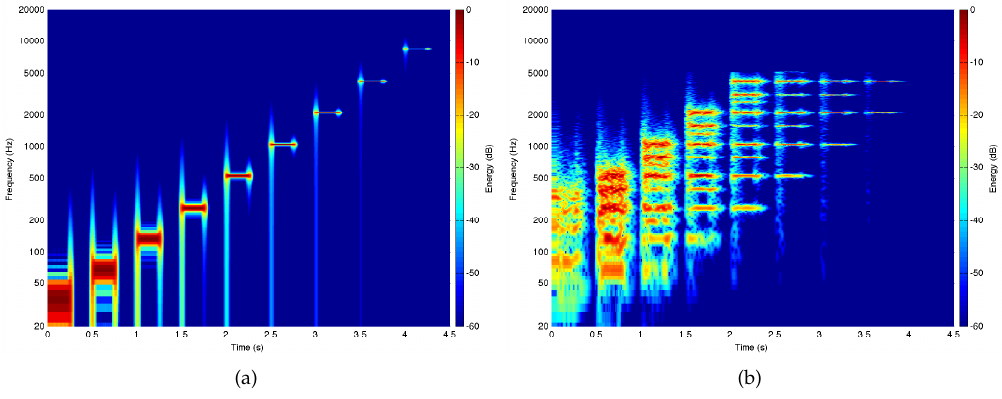
Figure 10. Showing range of Hammond tonewheels. ( a ) C0–C8 input signal; ( b ) Hammondizer with “shoutin’” registration.